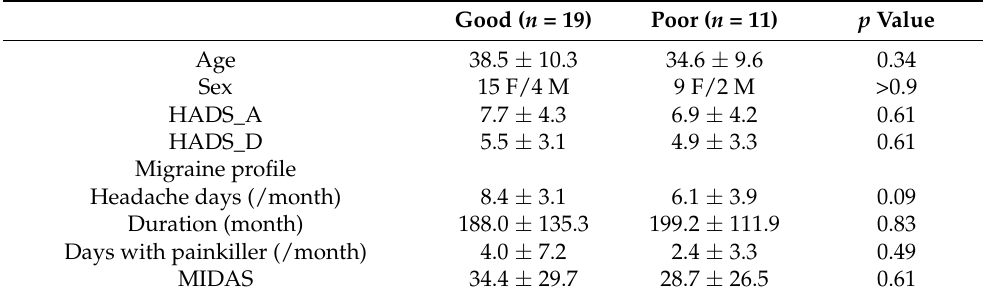
Table 2. Demographics, psychological characteristics and headache profile in EMs with different treatment outcomes.